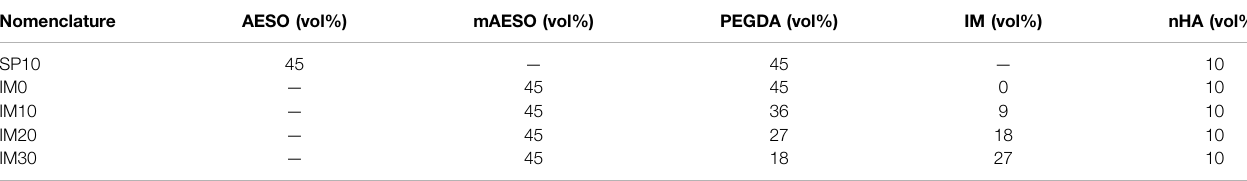
TABLE 1 | Nomenclature and composition of the